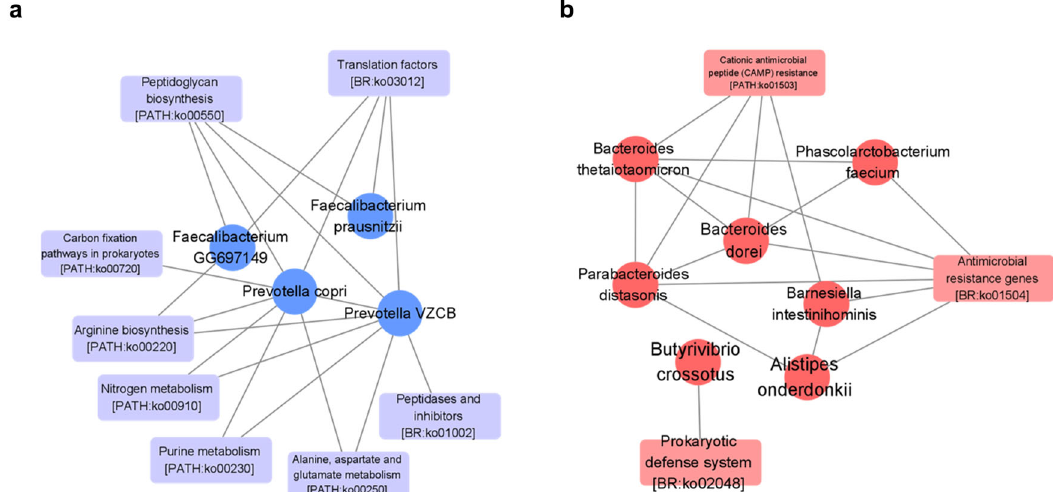
Fig. 5 Network analysis showing the correlations between gut bacterial species and function. a , b Network analysis of the 20 selected species and associated functional pathways. The nodes between functions were eliminated and only the edges that have signi fi cant correlations are shown. The minimum R value cut-off was 0.35. The red color represents species or functions that were less prevalent in Parkinson ’ s disease (PD) patients, and the blue colors represent those that were more prevalent in PD signatures associated with PD. Microbial gene markers for glutamate and arginine biosynthesis were downregulated in PD